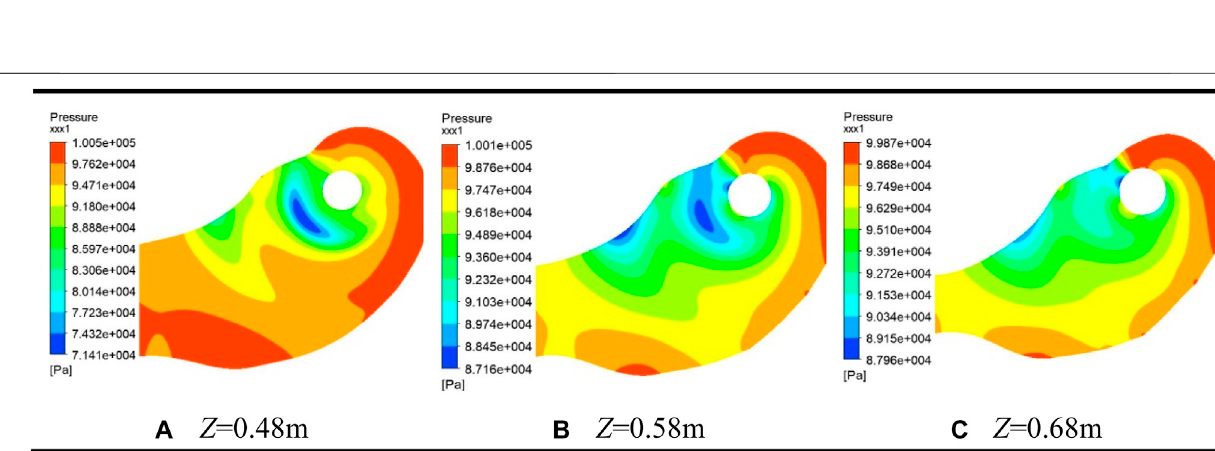
Frontiers in Energy Research |